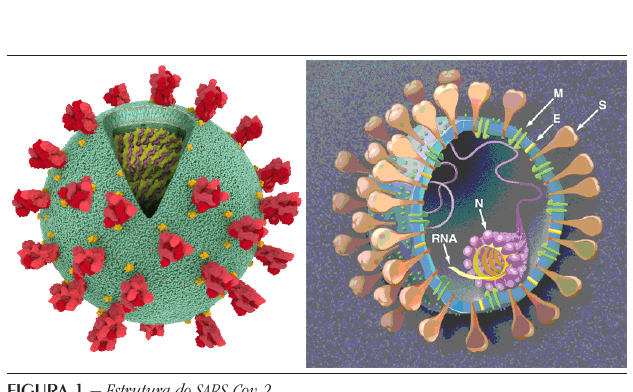
FIGURA 1 – Estrutura do SARS-Cov-2 Fontes: A) Corum J, Zimmer C (2020) (3) ; B) Holmes KV, Enjuanes L (2003) (4)